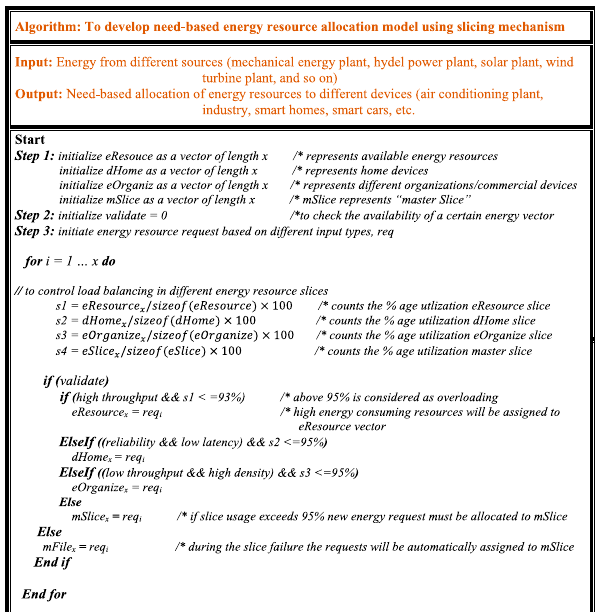
Algorithm 1. Algorithm for the proposed hybrid energy framework is mentioned below.